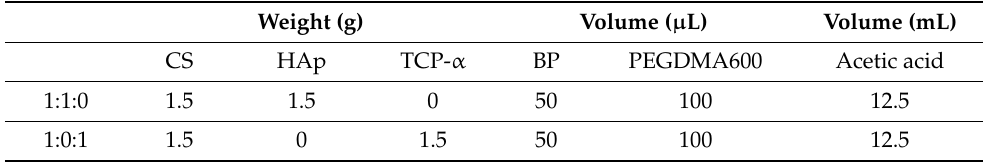
Table 3. Chitosan scaffold formulations with bioactive ceramics utilised for swelling, compression and biodegradation